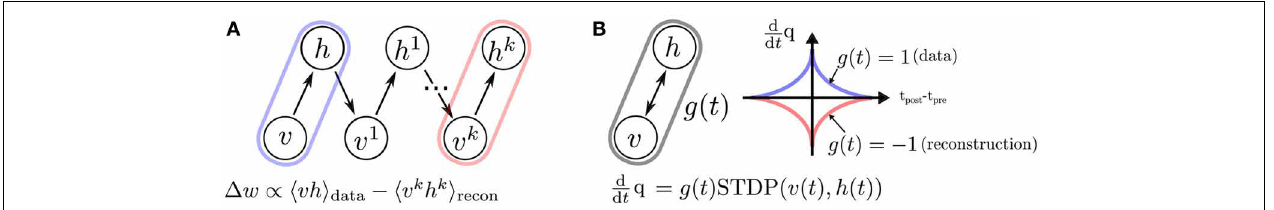
FIGURE 6 | The standard Contrastive Divergence (CD) k procedure, comparedtoevent-drivenCD.(A) InstandardCD,learningproceedsiteratively by sampling in “construction” and “reconstruction” phases (Hinton, 2002), which is impractical in a continuous-time dynamical system. (B) We propose a spiking neural sampling architecture that folds these updates on a continuous time dimension through the recurrent activity of the network. The synaptic